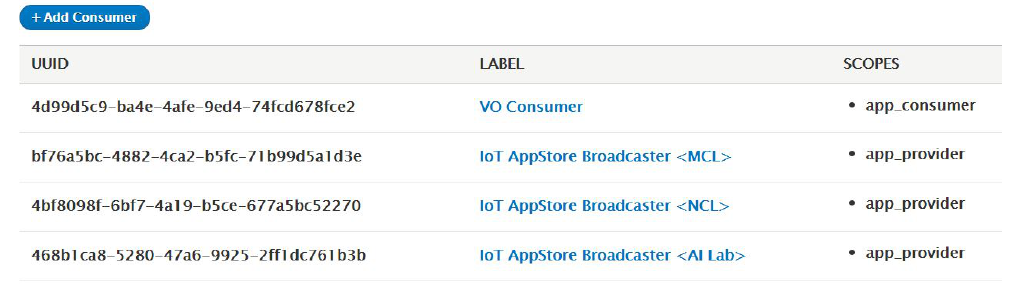
Figure 11. Client management on the application store.